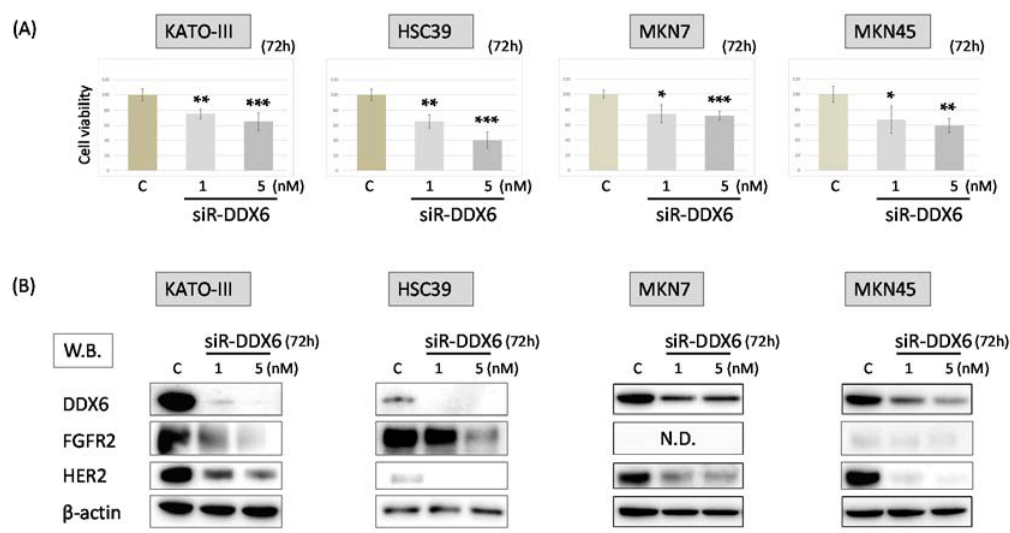
Figure 2. The knockdown of DDX6 in MKN7, MKN45, HSC39, and KATO-III cells by siRNA treatment. ( A ) Cell viability at 72 h after transfection of KATO-III, HSC39, MKN7, and MKN45 with siR-DDX6. C: control RNA, 5 nM. Controls are indicated as “100”; ( B ) Western blots of FGFR2, HER2, and DDX6 expression in KATO-III, HSC39, MKN7, and MKN45 cells at 72 h after transfection with control or siR-DDX6. The levels of controls are indicated as “1”. N.D.: not detected. Results are presented as the mean ± SD. * p < 0.05; ** p < 0.01; *** p < 0.001.